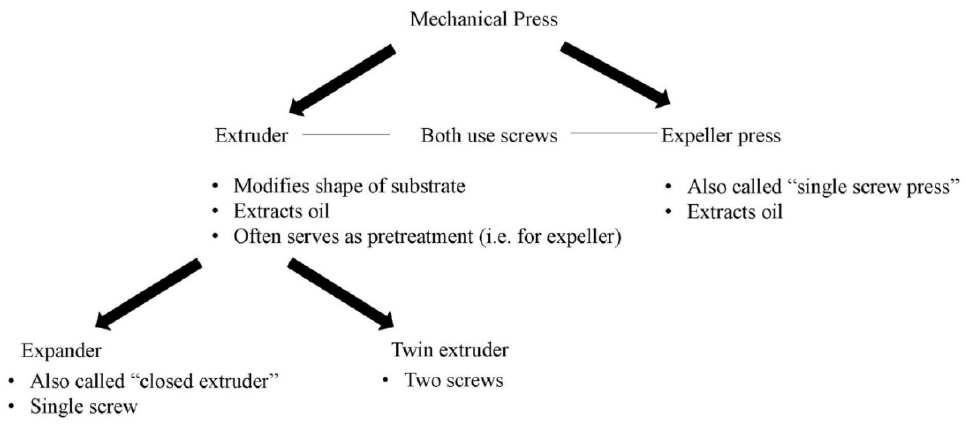
Figure 2. Major types of mechanical